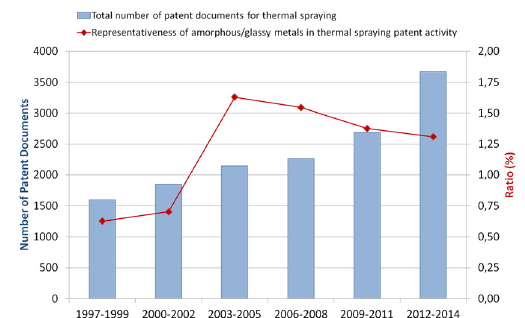
Figure 1. Number of patent documents in thermal spraying processes and relative percentage of amorphous alloys recovered from Derwent Innovations index in the period between 1997 and 2014. Source: Derwent Innovations